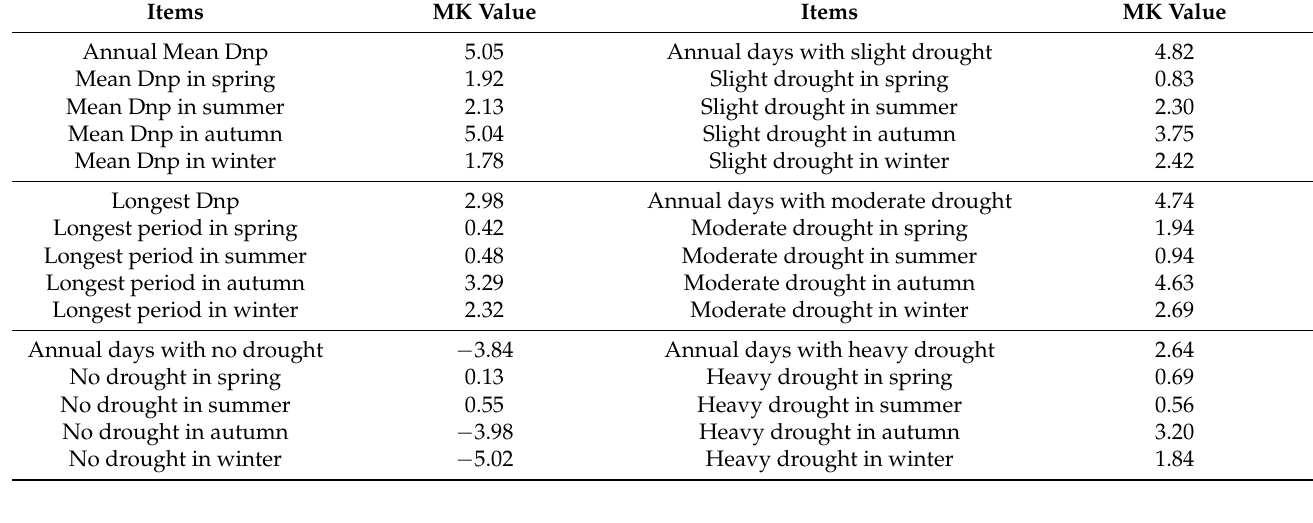
Table 1. MK values for different classifications of Dnp.